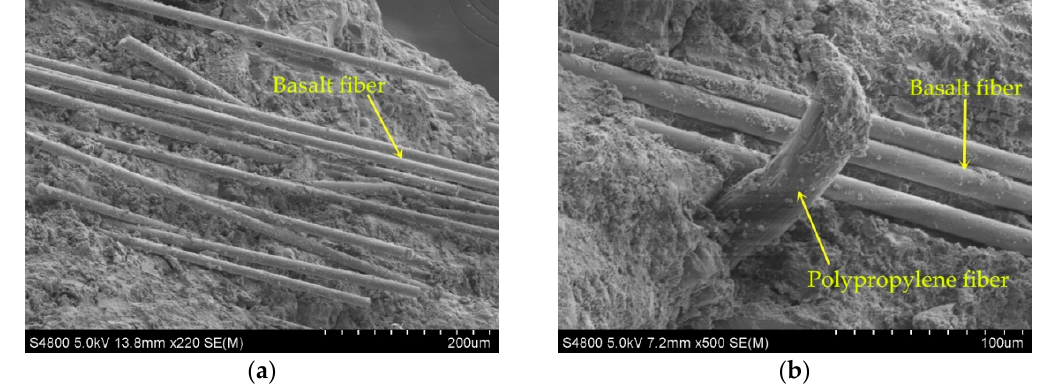
Figure 4. S canning electron microscopy (SEM) images of fibers. ( a ) Distribution of BF in basalt–polypropylene fiber-reinforced concrete (BPFRC). ( b ) Distribution of BF and PF in BPFRC.